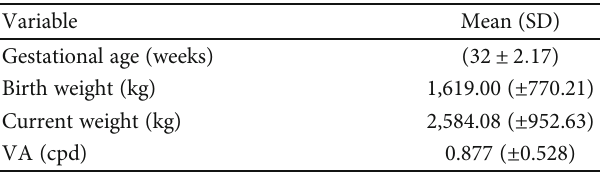
Figure 3: Sample fl owchart. Table 1: Descriptive characteristics of the